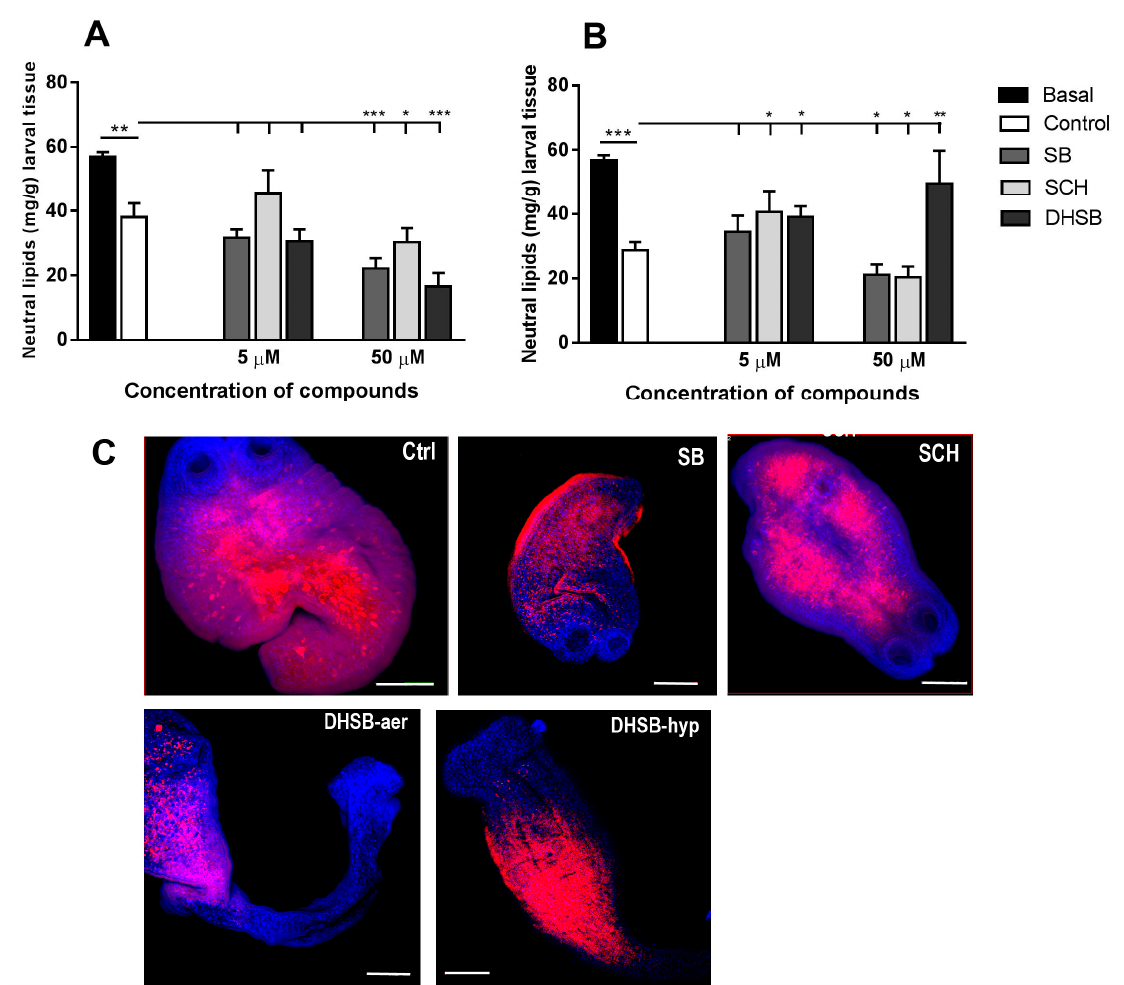
Figure 5. Neutral lipids concentration in larvae after isolation from mouse (basal), in control group and after in vitro treatment with SB, SCH and DHSB at 5 µ M and 50 µ M concentrations for 72 h under aerobic ( A ) and hypoxic ( B ) conditions. Whole-mount histochemistry and confocal laser scanning microscopy were used to demonstrate the localization of neutral lipids (red) and nuclei (blue) in larvae ( C ). Images show distribution pattern of lipids in control larvae and after treatment with 50 µ M of SB and SCH (upper panel), identical for both aerobic and hypoxic cultivations. Representative images of larvae after DHSB treatment (50 µ M, lower panel) showed different staining patterns for individual cultivations. Scale bar = 100 µ m, (SB) silybin; (SCH) silychristin; (DHSB) dehydrosilybin. Significantly different values from corresponding controls are shown as * p < 0.05, ** p < 0.01, *** p < 0.001.